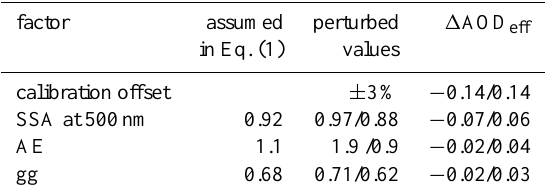
Table 3. Sensitivity of the effective aerosol optical depth (AOD eff ) to calibration offset and variations in aerosol optical properties. The sensitivity is shown as the deviation of AOD eff from a true AOD 500 = 0 . 3 at SZA = 45 ◦ as described more in detail in the text. SSA is the single scattering albedo, AE is the ˚Angstr¨om exponent and gg is the asymmetry parameter.